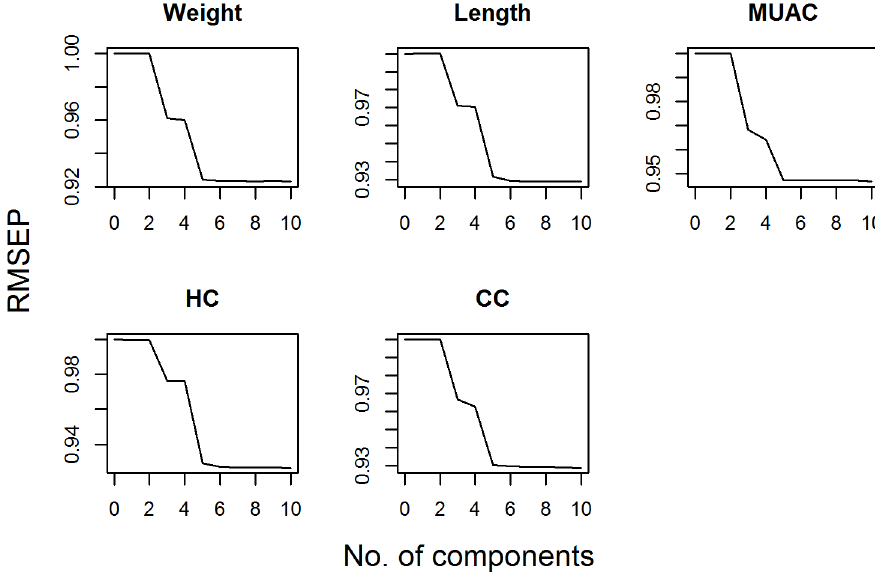
Fig 3. Root mean squared error of prediction (RMSEP) for different number of components of principal component regression